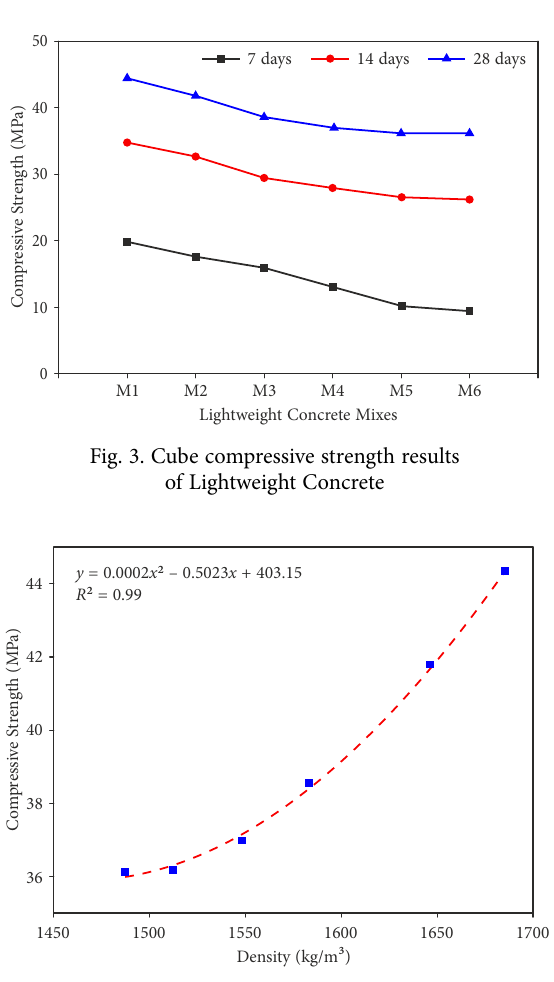
Fig. 4. Relation between Compressive Strength and Dry Density of Lightweight Concrete